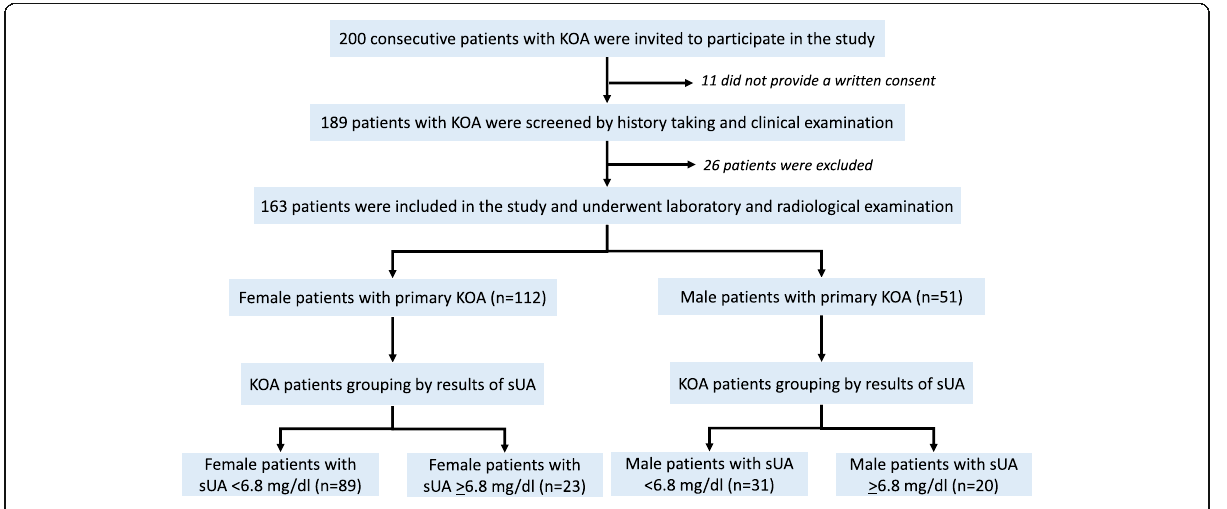
Fig. 1 Flowchart for KOA patients participated in the